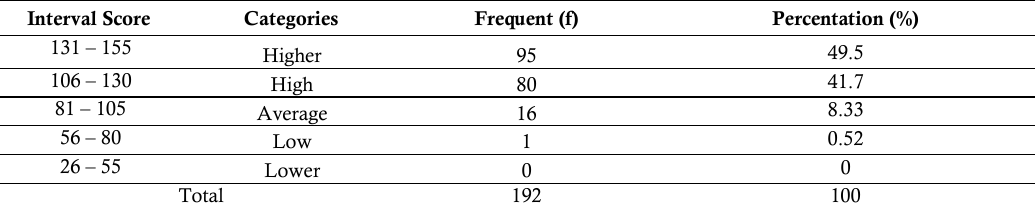
Table 1. Distribution Frequent based Score-Category Parent Support